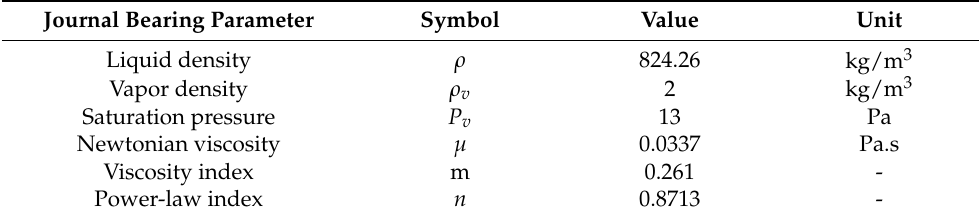
Table 2. Parameters of 10w40 oil at temperature of 55 ◦ C